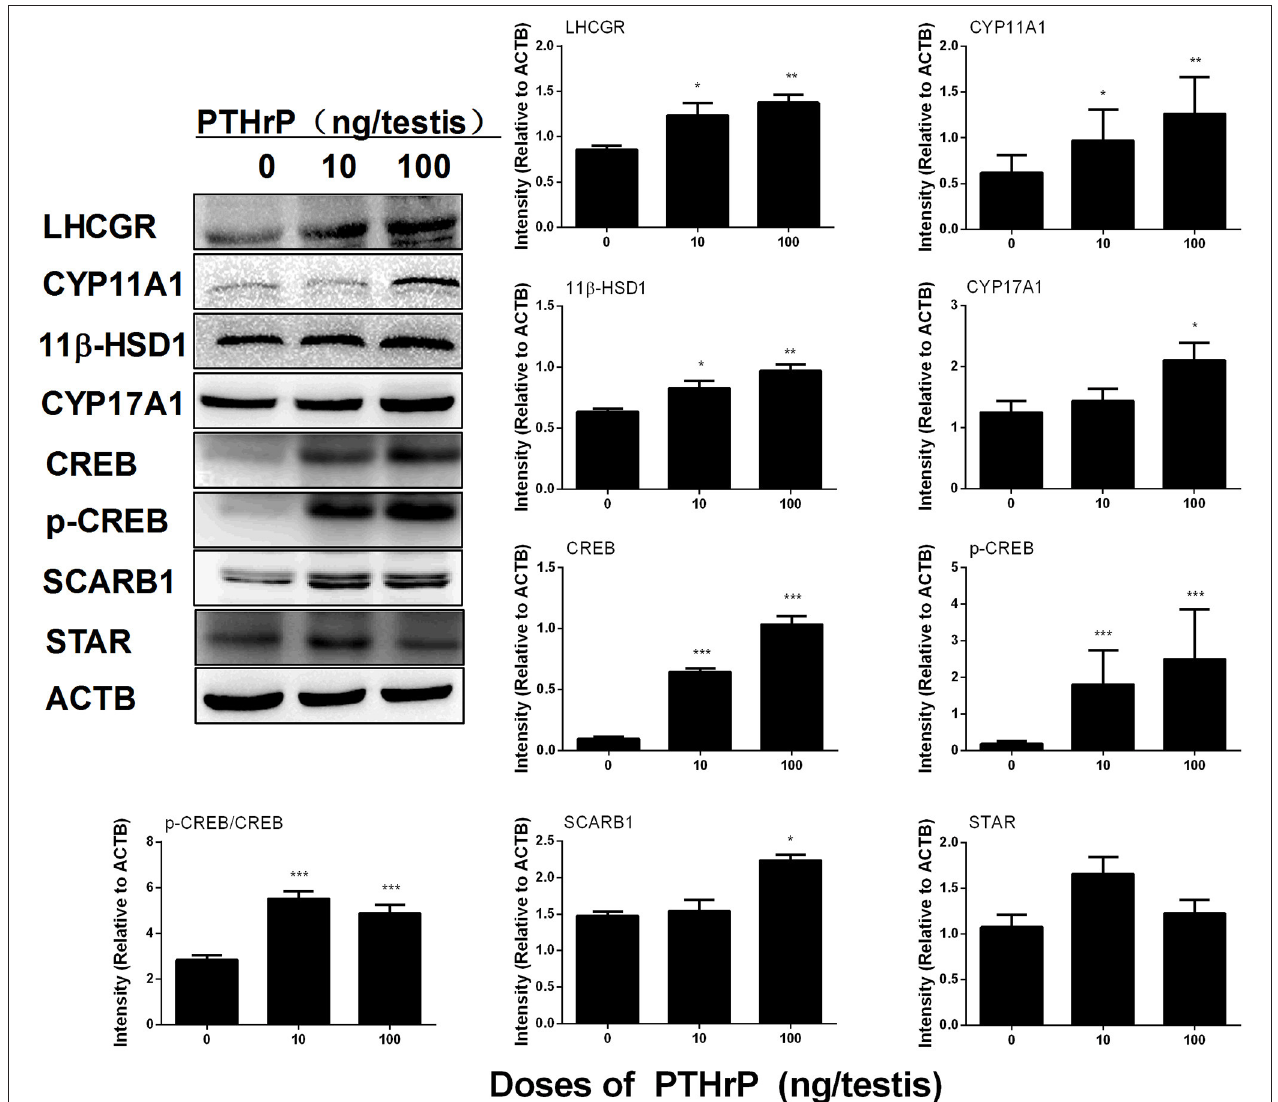
FIGURE 8 | PTHrP affects Leydig cell-specific protein levels in vivo . Left panel: gel; Right panel: quantitative data. The protein levels of LHCGR, CYP11A1, CYP17A1, 11 β -HSD1, CREB, p-CREB, CREB/p-CREB, SCARB1, STAR, and ACTB (internal control) were analyzed by Western blot in testes from the rats treated with 0, 10, and 100 ng/testis PTHrP on post-EDS day 7 for 21 days. Mean ± SEM, n = 4–5, * P < 0.05, ** P < 0.01, and *** P < 0.001 when compared to the control.